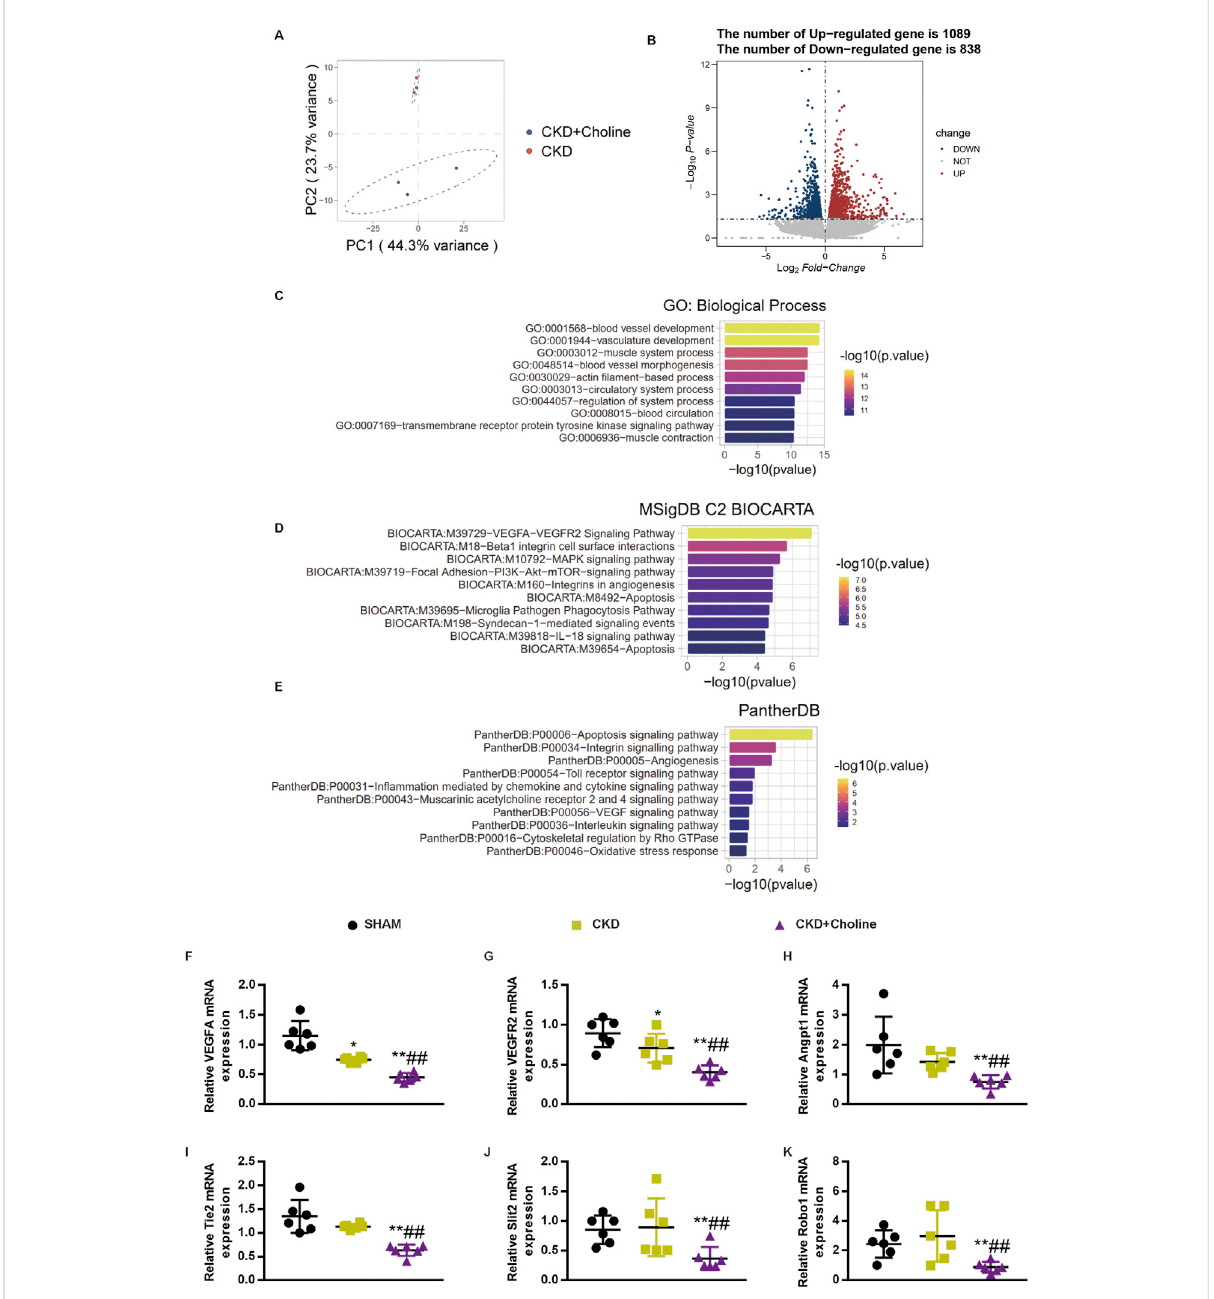
FIGURE 5 RNA-sequencing analysis revealed that dietary choline (1.2%) affected cardiac angiogenesis in 5/6Nx mice (A) PCA results suggested good separation betweenthethreegroups. (B) Volcano plotofdifferentially expressed genes. X axis: log 2 (FC); Y axis:-log 10 P. Red represents upregulated genes,andbluerepresentsdownregulatedgenes. (C) GOenrichmentanalysisofthedifferentiallyexpressedgenesbetweenCKDandCKD+Choline group (D) Pathway analysis the differentially expressed genes according to the MSigDB (E) Pathway analysis the differentially expressed genes according to the Panther program. (F – K) The mRNA levels of VEGF, Angpt1, Slit2, VEGFR2, Tie2 and Robo1 were measured by real-time PCR. The data are presented as the mean ± SD. * p < 0.05 and ** p < 0.01 vs. SHAM group; # p < 0.05 and ## p < 0.01 vs. CKD group. & p < 0.05 and && p < 0.01 vs. CKD + Choline group. n = 6 in each